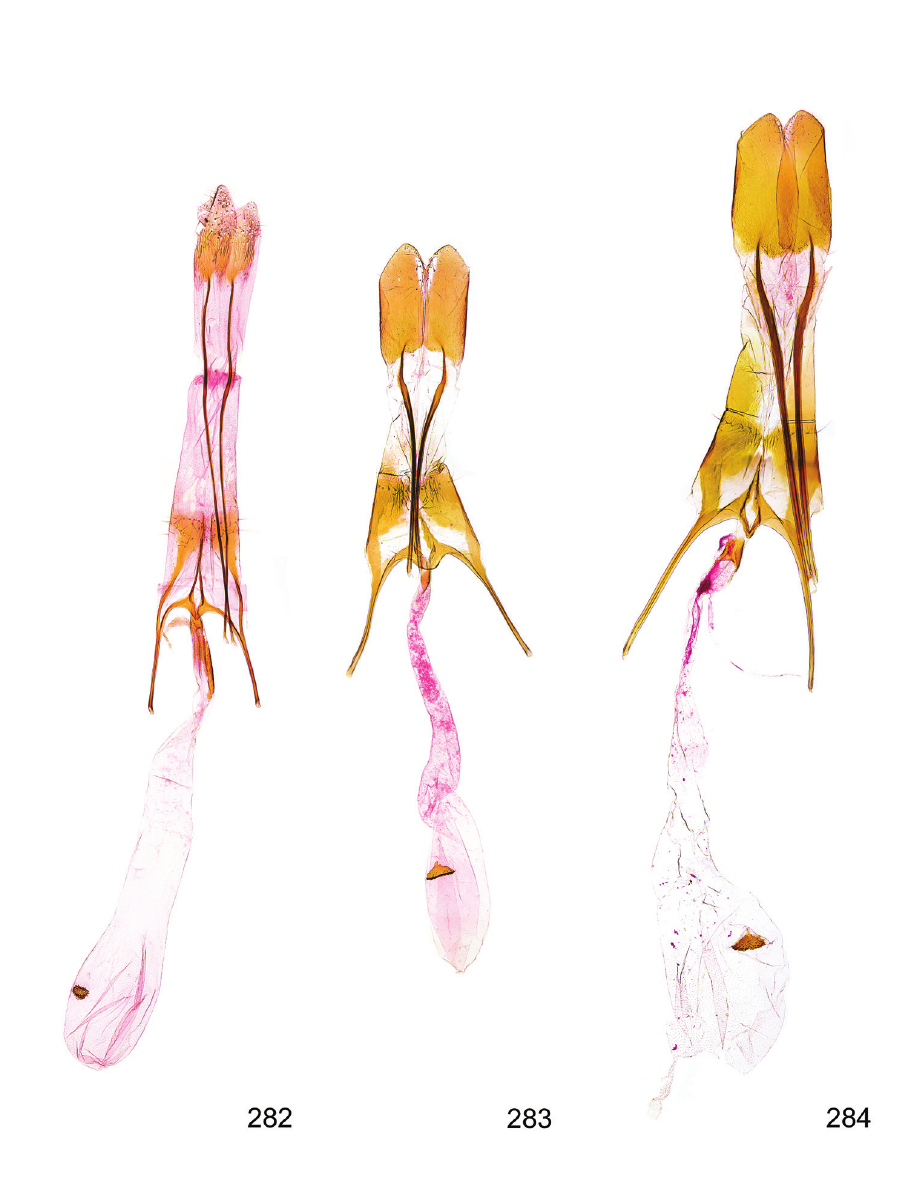
Figures 282–284. Megacraspedus female genitalia. 282 M. libycus sp. n. – Paratype, Morocco, GEL 1266 P.H. (TLMF) 283 M. albovenata Junnilainen, 2010 – Czech Republic, GU 17/1474 P.H. (NMPC) 284 M. longipalpella Junnilainen, 2010 – Ukraine, GU 17/1475 P.H.